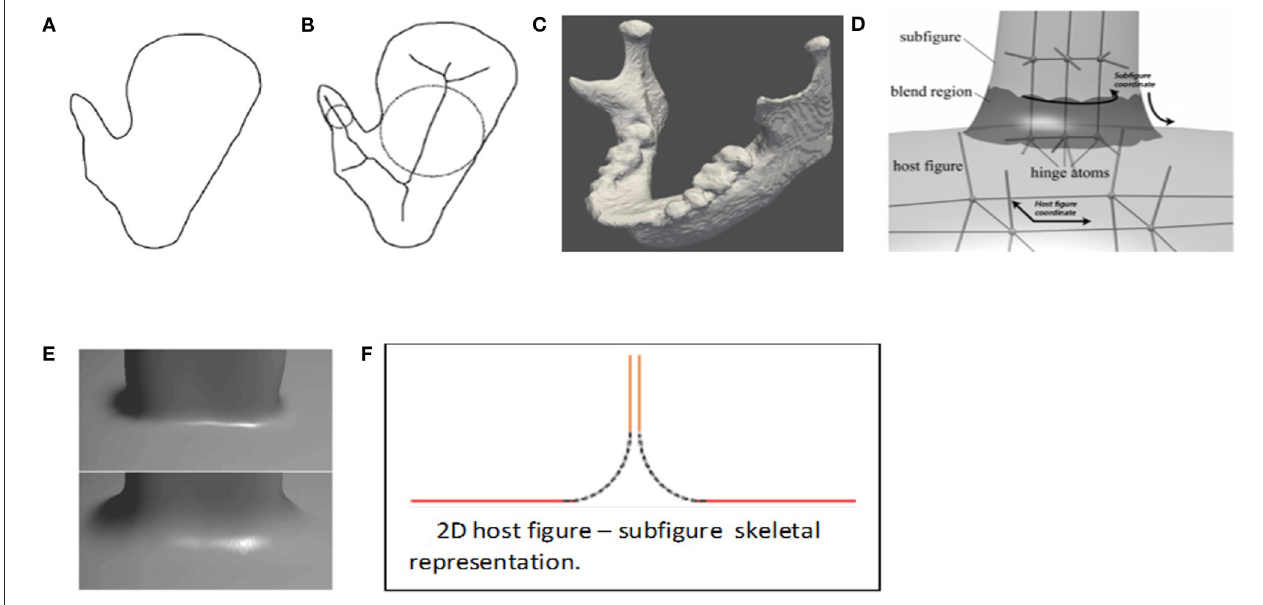
FIGURE 8 | (A) A 2D figure with a protrusion. (B) The Blum representation of that object. (C) The mandible, with its protrusions. The (D) Han representation of object a [copied from Han et al., 2005]. The s-reps for the host figure and subfigure are attached by a skirt (darkened) connecting a cut through the subfigure to a one-sided hole in host figure skeleton. (E) At the figure, subfigure connection the boundary implied by (D) , for two different values of the blending parameter. (F) The skeletal arrangement for a host figure and subfigure, in 2D. The pairs of parallel lines are understood as collocated. The host figure is indicated by the red and blue lines; its bottom side (blue) has spokes facing downward, and its top side (red) has spokes facing upward. The top side has a hole in which the subfigure is fit. The subfigure skeleton (orange) is connected to the host figure skeleton by the skirt (dashed, black); together they have spokes facing right and left.